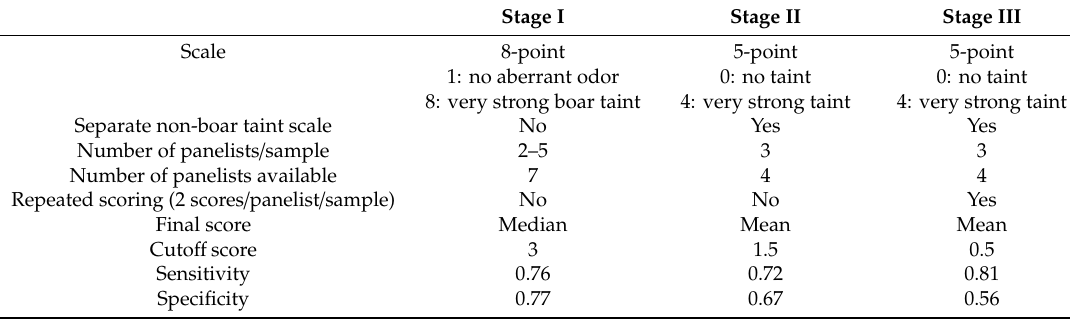
Table 1. Comparison of the scoring system used in the study by the olfactory panel (with hot iron method) during the study in stage I, II, and